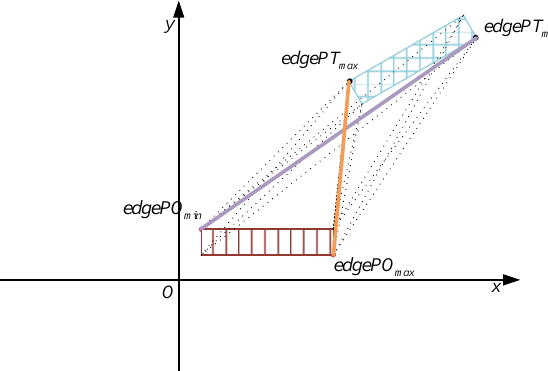
Figure 3. Selecting the critical collision point by slope (scenario 1).